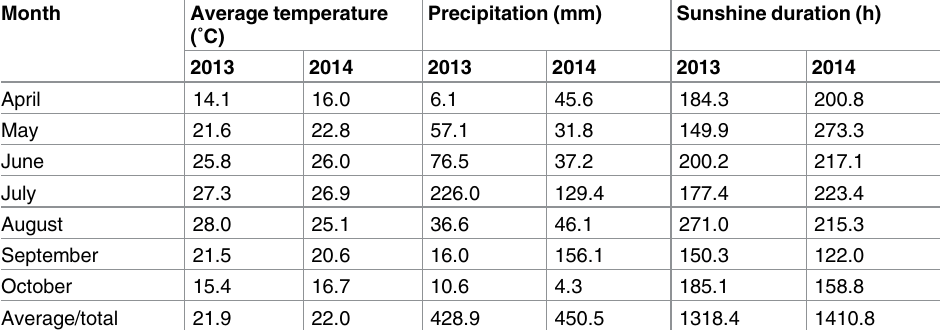
Table 1. Monthly weather summaryduring the cotton growing season in 2013and 2014 at Anyang, Henan, China.